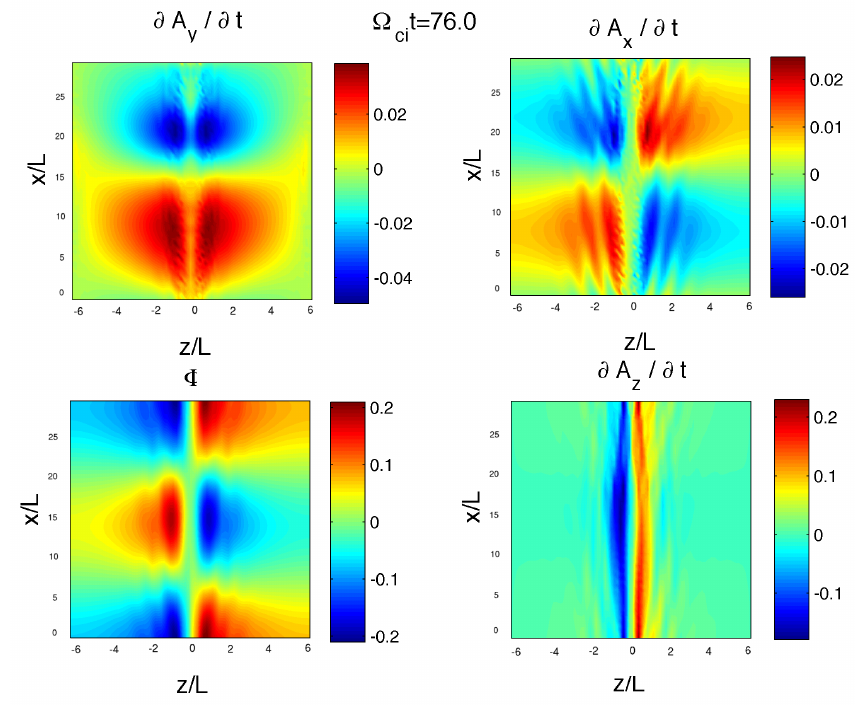
Fig. 7. Scalar potential and the three components of the time deriva- tive of the vector potential are shown in the four panels at time t = 76 for a run starting from the initial force-free reversed field equilibrium with S = 10 4 and R v = 10 4 (same run considered in Fig. 2). The different components are listed above each label. = 10 4 (same run considered in v